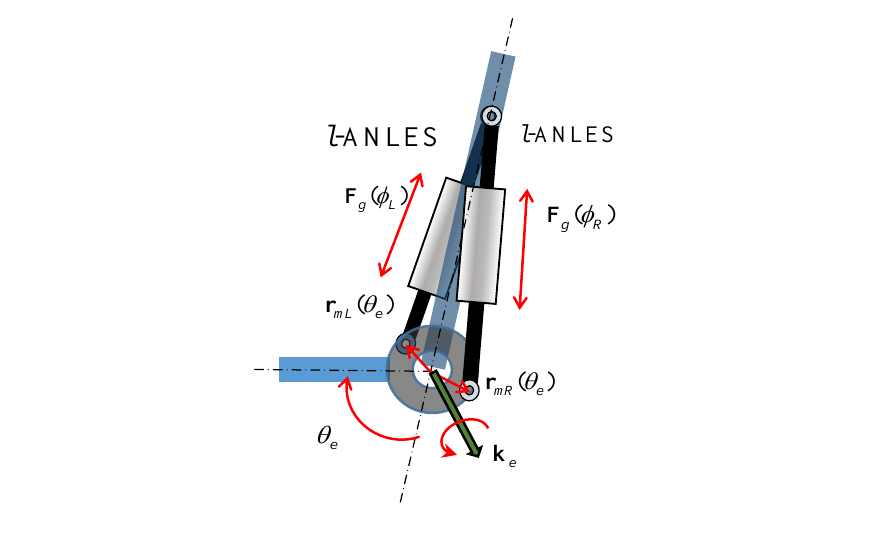
Figure 6. A rotary joint controlled by a pair of l-